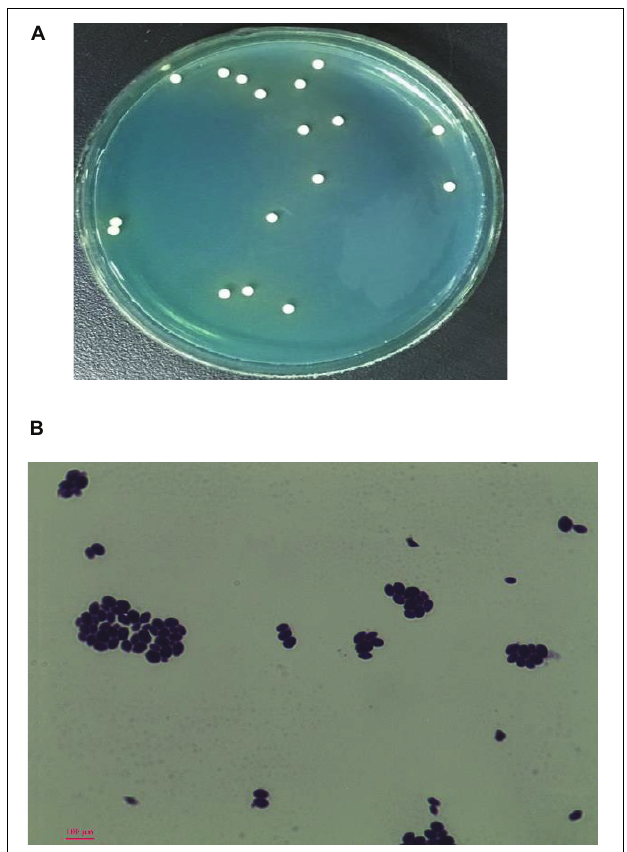
FIGURE 1 | Colony morphology on WL (A) and cell morphology (B) of strain YX3307 captured by microscopy (10 × 40). Cell was stained by the crystal violet method. The asexual budding reproduction occurred at the ends of the cells was highlighted in the blue circle.